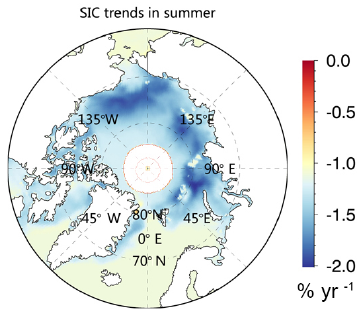
Figure 15. Summer SIC trends over the period